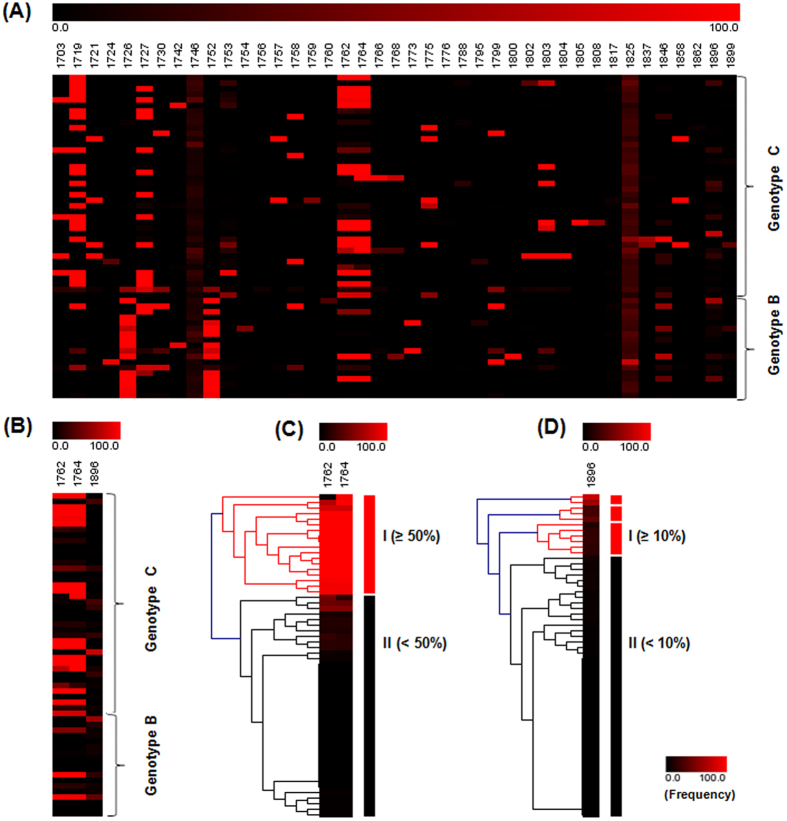
Mutation spectrum and hierarchical clustering analysis of BCP and PC mutants.(A) Quasispecies spectrum of mutants in the EnhII/BCP/PC regions in 58 HBeAg-positive CHB patients. (B) Combinational patterns of BCP A1762T/G1764A and PC G1896A mutants. Hierarchical clustering analysis of (C) BCP A1762T/G1764A and (D) PC G1896A mutants.